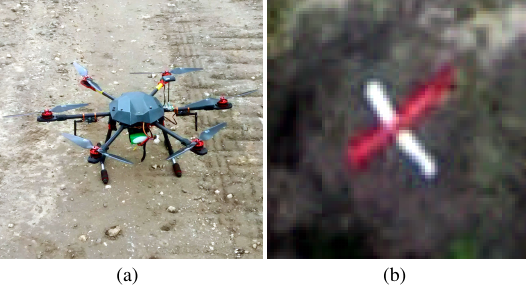
Figure 2. UAV used and markers for signalling GCP. (a) Hexacopter Tarot 680 PRO; (b) Marker in the form of a cross to mark the